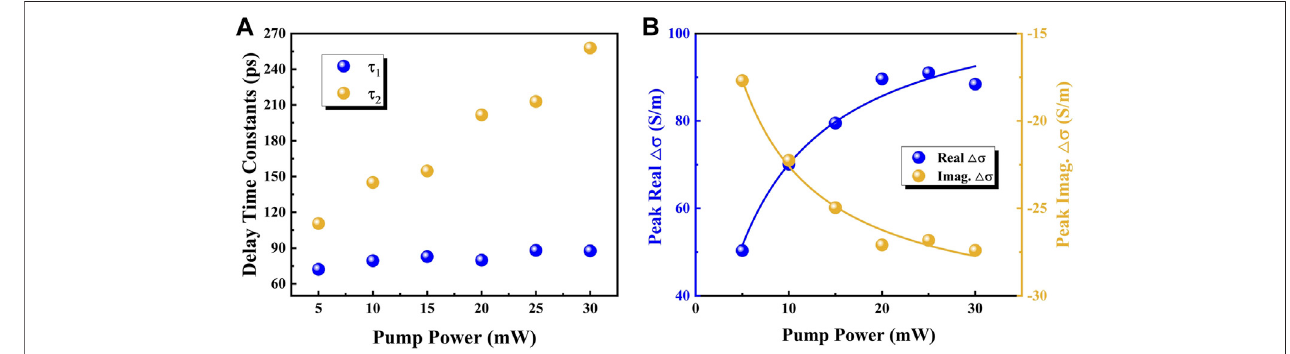
FIGURE 4 | (A) Time constants extracted from the exponential fi ttings for the real and imaginary parts of the complex conductivity. (B) Real (imaginary) part of the complex conductivity at maximum (minimum) points as a function of pump power.